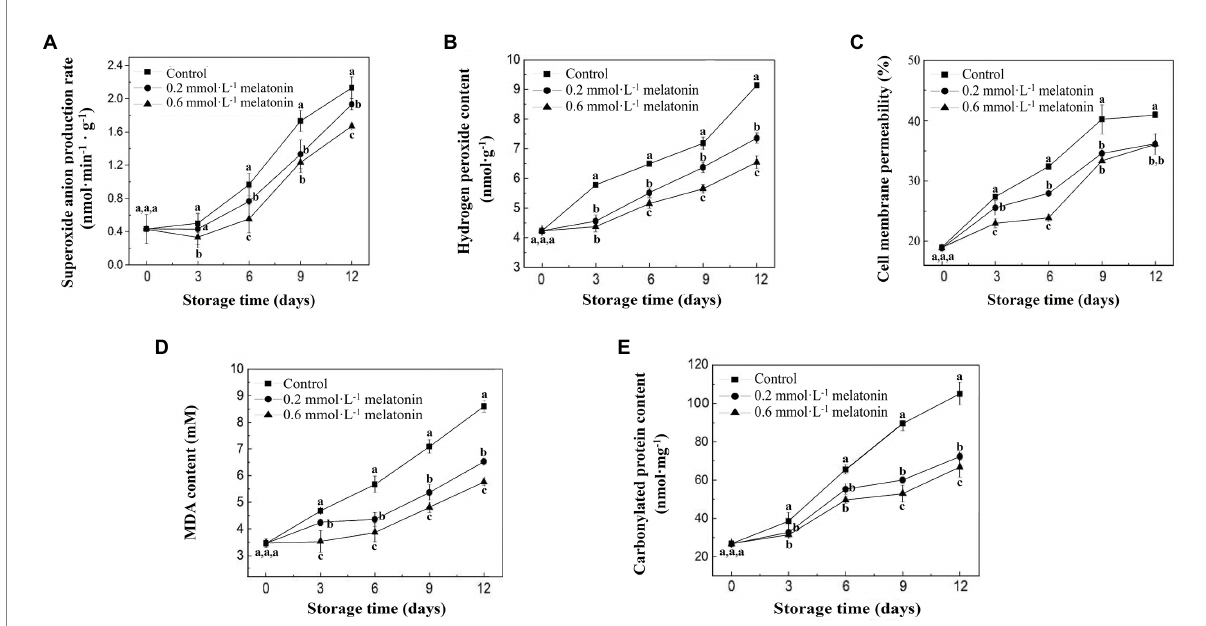
FIGURE 3 (A) O 2 − production rate, (B) H 2 O 2 content, (C) cell membrane permeability, (D) MDA, and (E) protein carbonyl content of the peel samples during cold storage. Data represent mean values and standard errors of three replicates. Different lowercase letters (a–c) indicate significant differences between different groups ( p <